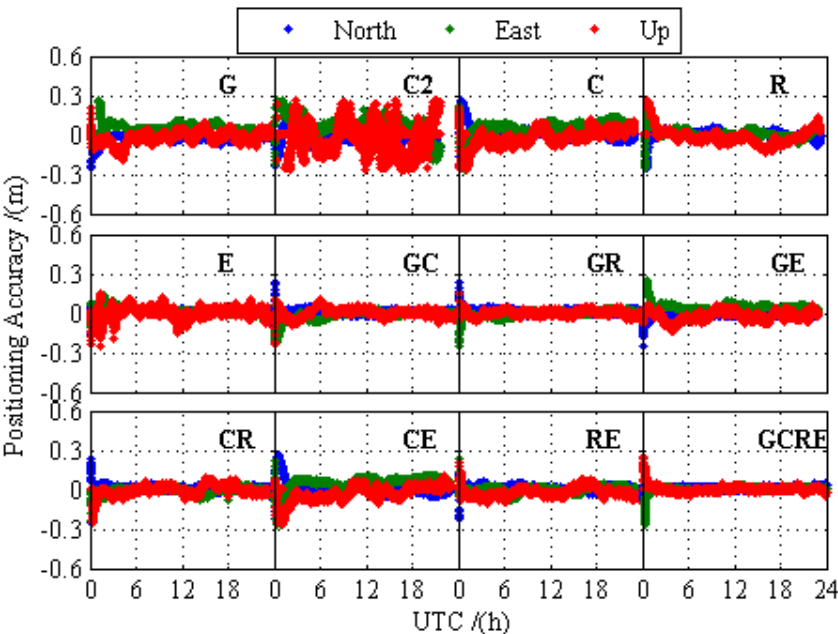
Figure 7. Kinematic PPP positioning errors at KUN1 for 12 different processing cases on DOY 024 in 2019.